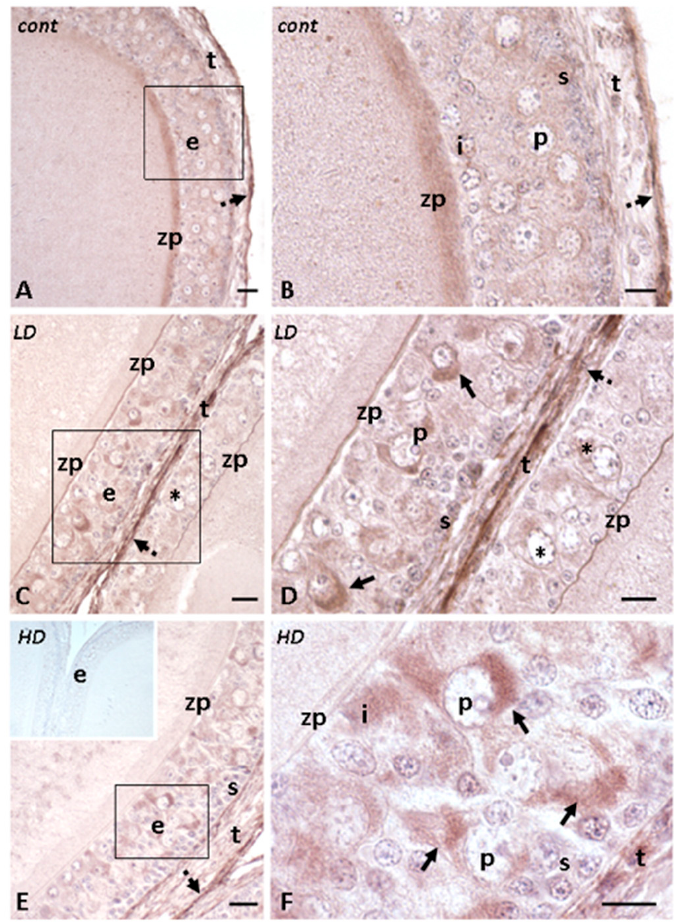
Figure 6. Immunohistochemical localization (brown areas) of E-cadherin in follicles of P. siculus treated with glyphosate (low LD and high HD doses). ( A , B ) Diffuse signal on the zona pellucida and follicular cells. Note the intense signal on theca externa (dotted arrows). ( C , D ) Intense signal (arrows) on the cytoplasm of occasional pyriform (P) cells and on theca (t). The epithelium (e) in a smaller oocyte is almost unstained and shows apoptotic pyriform cells (*). Zona pellucida (zp) is always stained. ( E , F ) Signal is on most pyriform (P), intermediate (I), and theca cells (t). E inset: negative control of the reaction. Scale bars: left images, 40 µm; right images, 20 µm.